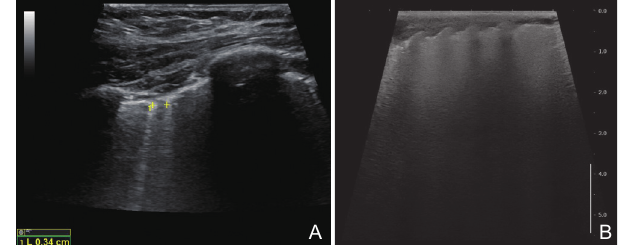
Figure 7 B-line and white lung. (A) Ultrasound shows a comet tail- like strong echo originating from the pleural line and perpendicular to the pleural line. Here, the distance between the B-line is about 3mm (B3-line); (B) The B-line is densely distributed and cannot be distinguished from each other, and even the rib sound shadow is disturbed. The entire lung field is occupied by a "white" hyperechoic area (white lung).